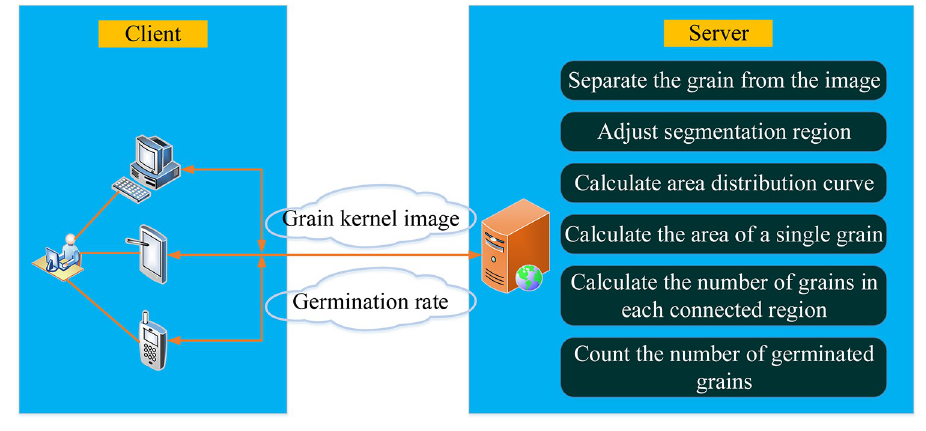
Fig 1. The system diagram.